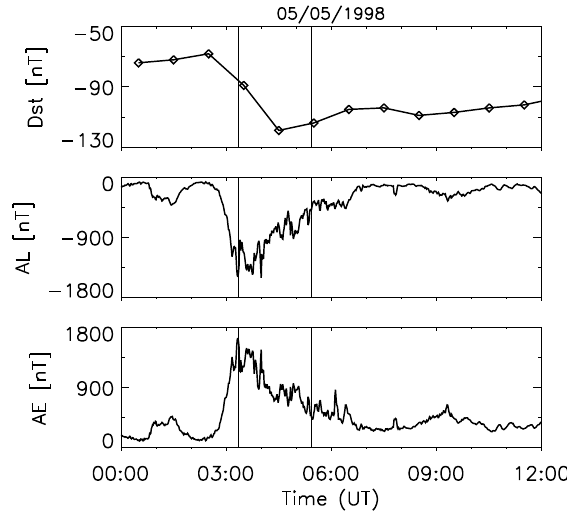
Fig. 2. The AE, AL and D st -indices between 00:00 and 12:00 UT on 5 May 1998. The two vertical solid lines indicate our time inter- val with data between 03:20 and 05:25 Fig.2. TheAE,ALandDst-indices between0000and1200UTonMay5,1998. Thetwovertical solid lines indicate our time interval with data between 0320 and 0525 UT.